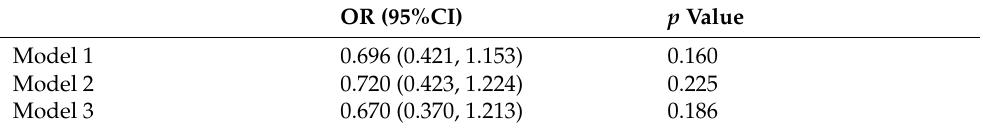
Table 2. Associations of malnutrition with risk of depression in patients after acute ischemic stroke.